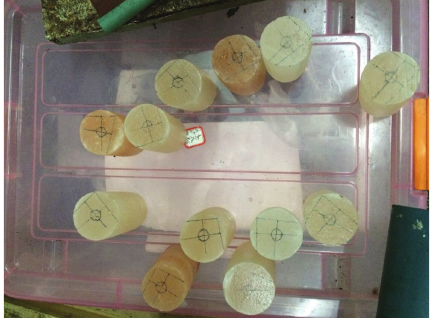
Figure 1: Rock salt